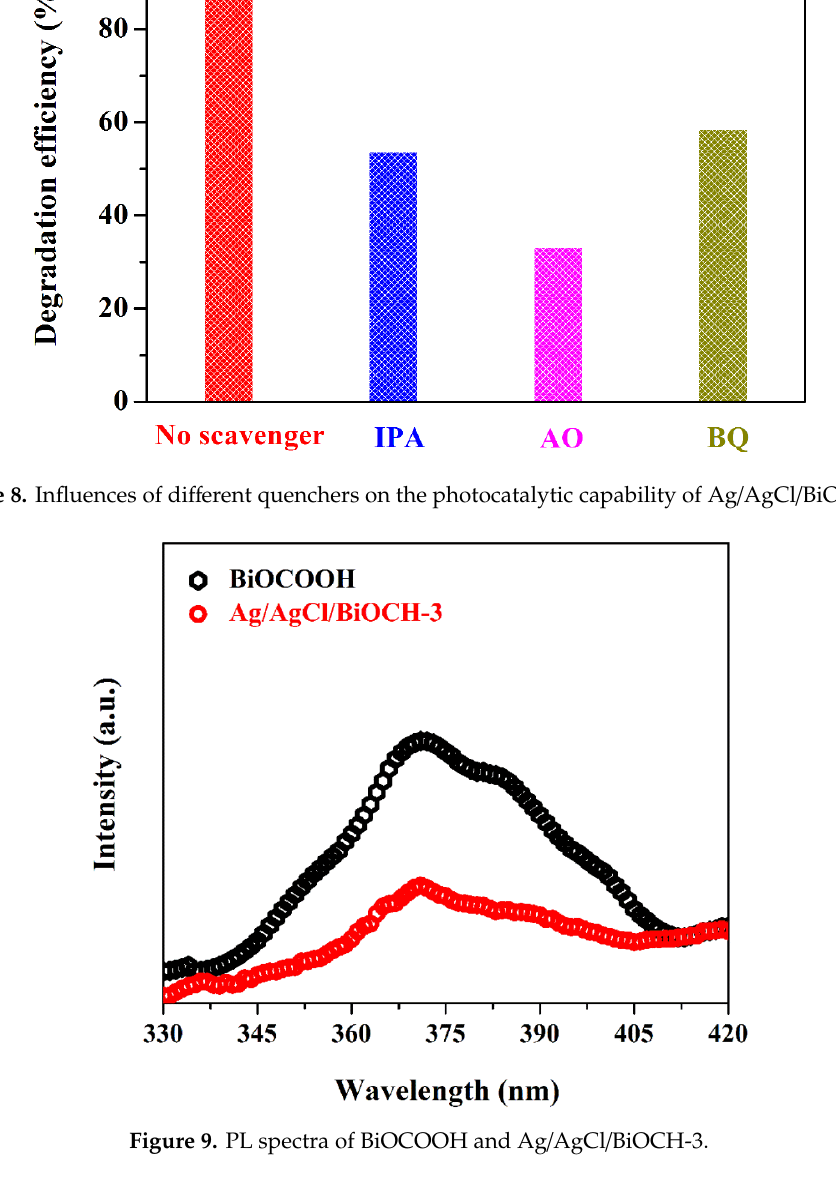
Figure 9. PL spectra of BiOCOOH and Ag/AgCl/BiOCH-3.